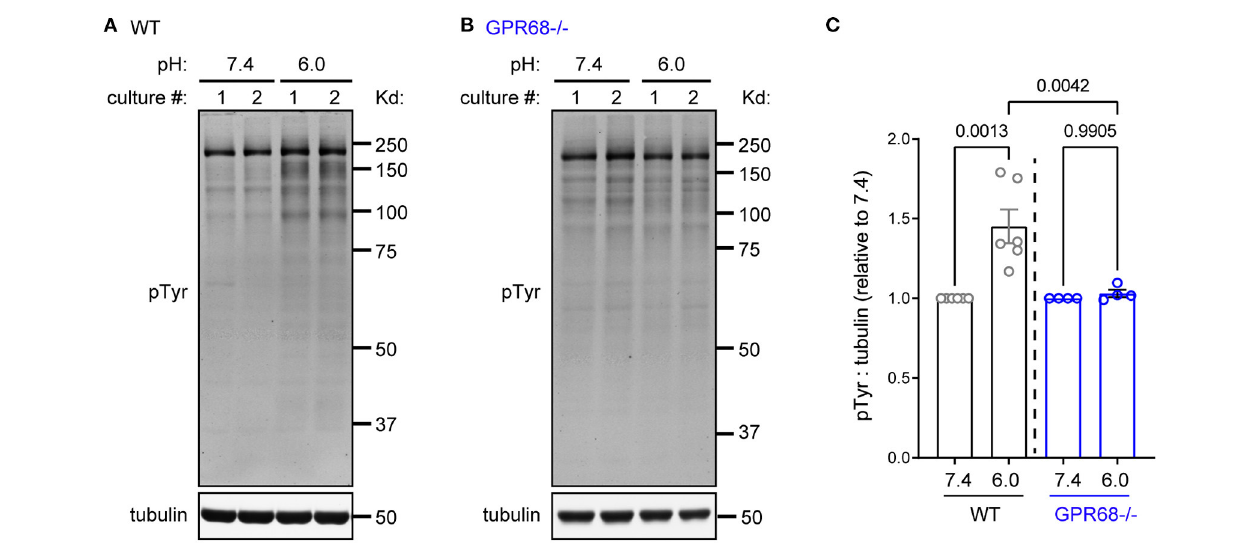
FIGURE 6 | GPR68 mediates acidosis-induced tyrosine phosphorylation. Representative Western blot (A,B) and quantification (C) of 1-h pH 6-induced tyrosine phosphorylation in WT (A) and GPR68 − / − (B) hippocampal slices. Blots and images were representative from 4 to 6 different cultures/pups (see Methods or Figure 2 Legends for additional clarification). P -values were from 2-way ANOVA with Tukey’s